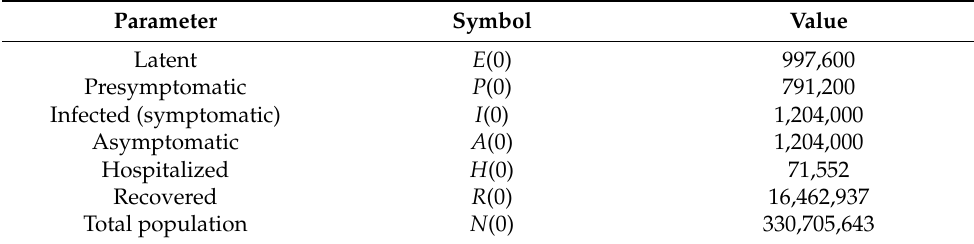
Table 1. Initial conditions assumed for the different